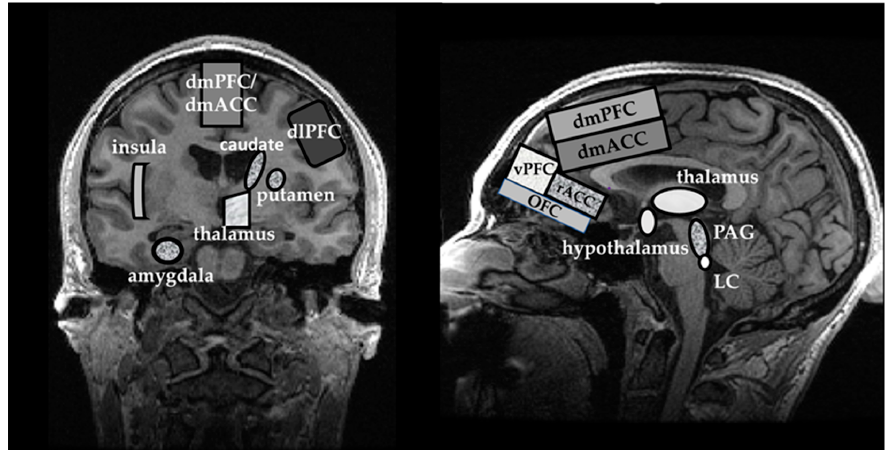
Figure 1. Anatomical structures involved in the ‘fear neurocircuitry’: Coronal view ( left ), Sagittal view ( right ). Abbreviations: dmPFC, dorsomedial Prefrontal Cortex; dmACC, dorsomedial Anterior Cingulate Cortex; dlPFC, dorsolateral Prefrontal Cortex; vPFC, ventral Prefrontal Cortex; rACC, rostral Anterior Cingulate Cortex; OFC, Orbitofrontal Cortex; PAG, Periaqueductal Gray; LC, Locus